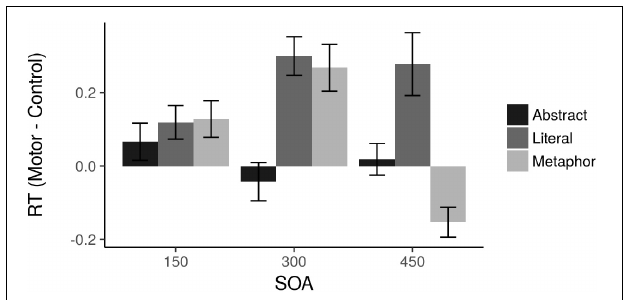
FIGURE 2 | Effects of TMS on RTs. Positive values represent slower RTs following